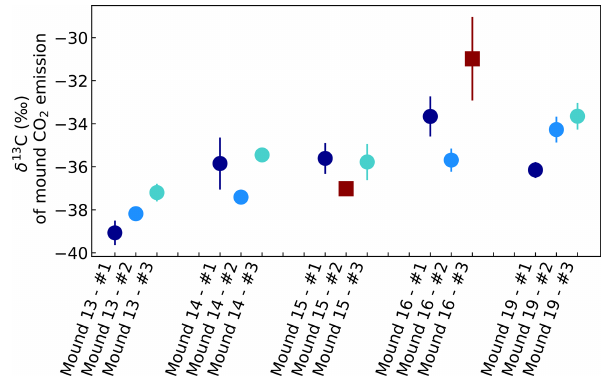
Figure A2. δ 13 C of CO 2 emitted by mounds nos. 13–19, derived by use of Keeling plots. Error bars represent the standard error of the linear regression intercept. Red squares indicate intercepts based on linear regression fits with R 2 < 0 . 99 or based on linear regres- sion with only two instead of three sample points. All mounds were measured three times during one week, and each series no. was measured on the same day and in the same order. Averages were calculated for each mound, which were − 38 . 1‰ (mound no. 13, se = 0.9), − 36 . 2‰ (mound no. 14, se = 1.0), − 35 . 7‰ (mound no. 15, se = 0.1), − 34 . 7‰ (mound no. 16, se = 1.4), and − 34 . 7‰ (mound no. 19, se = 1.3). For calculation of these averages, values with a linear regression of R 2 < 0 . 99 or values based on a linear re- gression of only two measurements (indicated as dark red squares) were